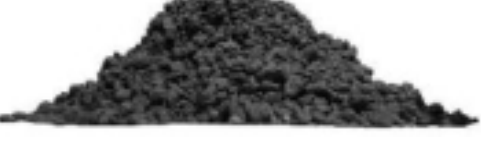
Figure 8. Grayscale image.